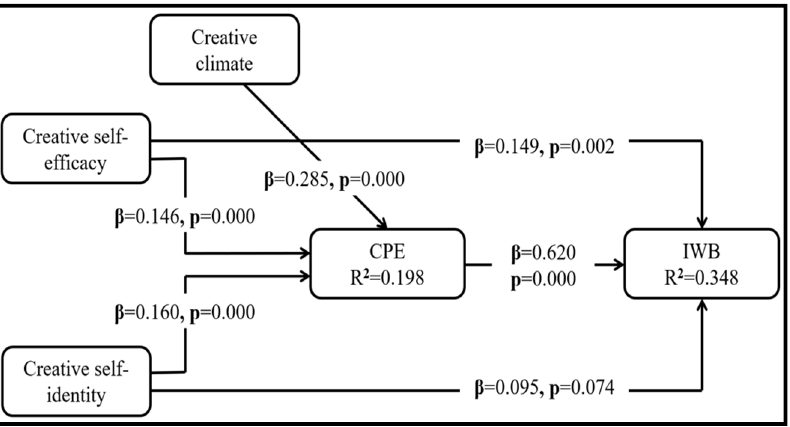
Figure 2. Structural model. CPE = Creative process engagement; IWB = Innovative work behaviour.